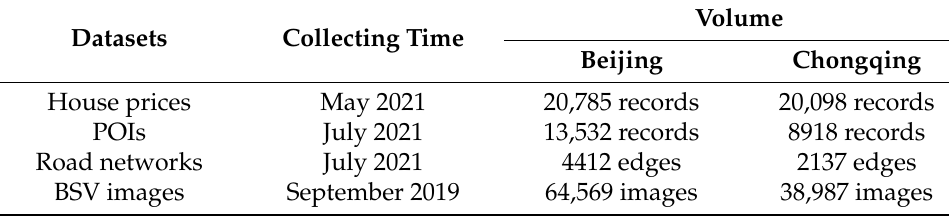
Table 2. Time and volume of the data